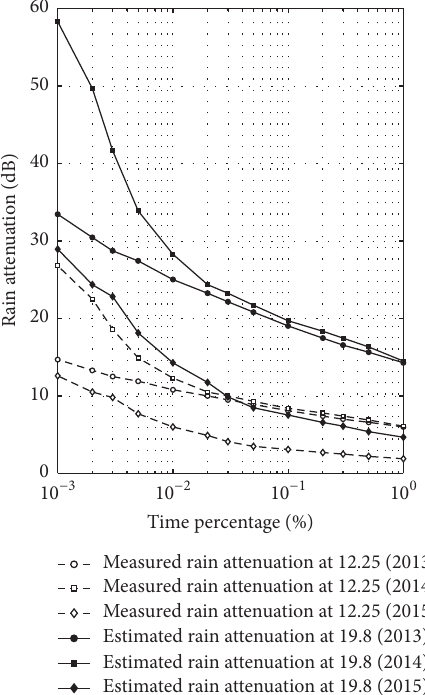
Figure 12: Plot between predicted error and 1-minute rainfall rate.